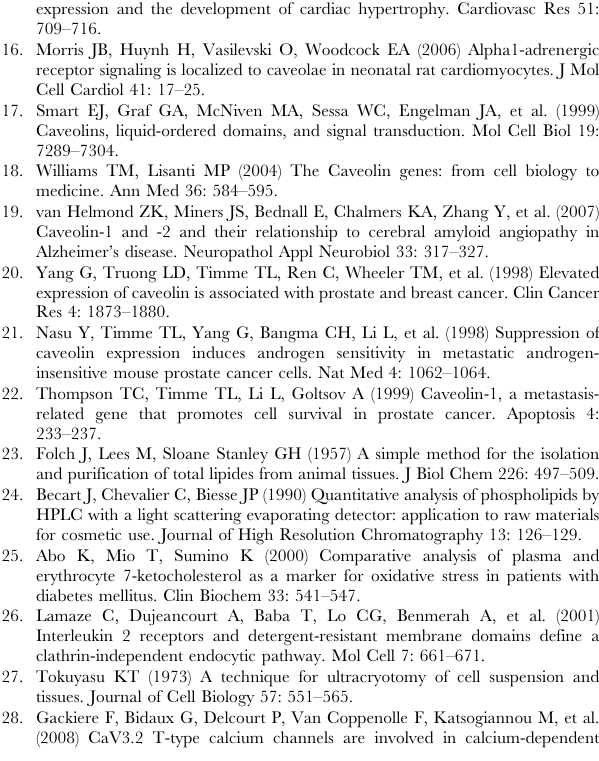
Figure S1 Representative cell cycle profiles of propidium